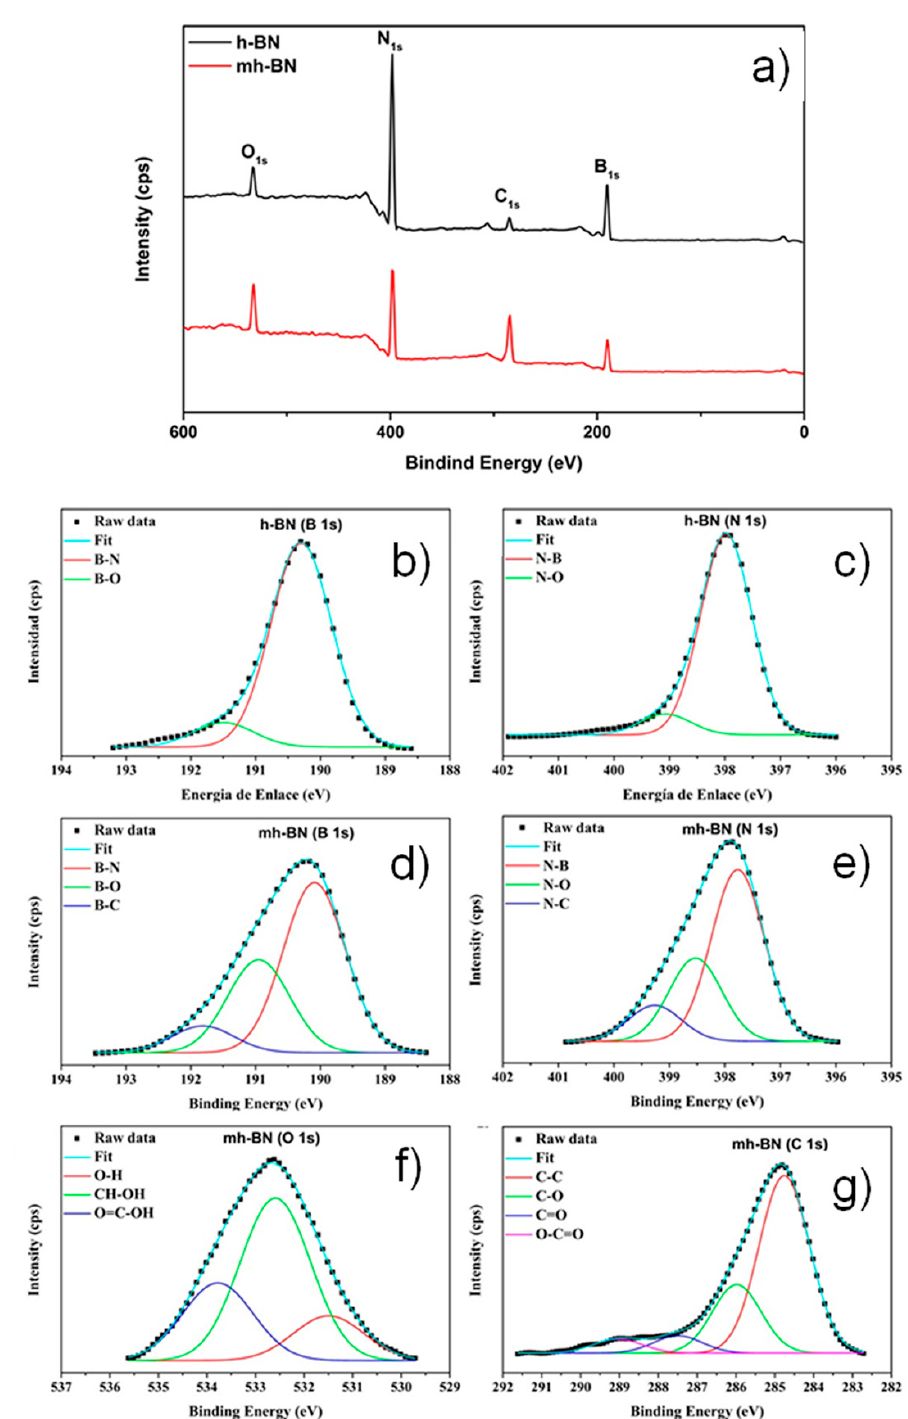
Figure 5. ( a ) X-ray photoelectron spectroscopy (XPS) survey spectra of unmodified (h-BN) and plasma-modified (mh-BN) nanoparticles, and the high-resolution XPS spectra of: ( b ) B 1 s and ( c ) N 1 s from h-BN; ( d ) B 1 s , ( e ) N 1 s , ( f ) O 1 s ; and ( g ) C 1 s from mh-BN.